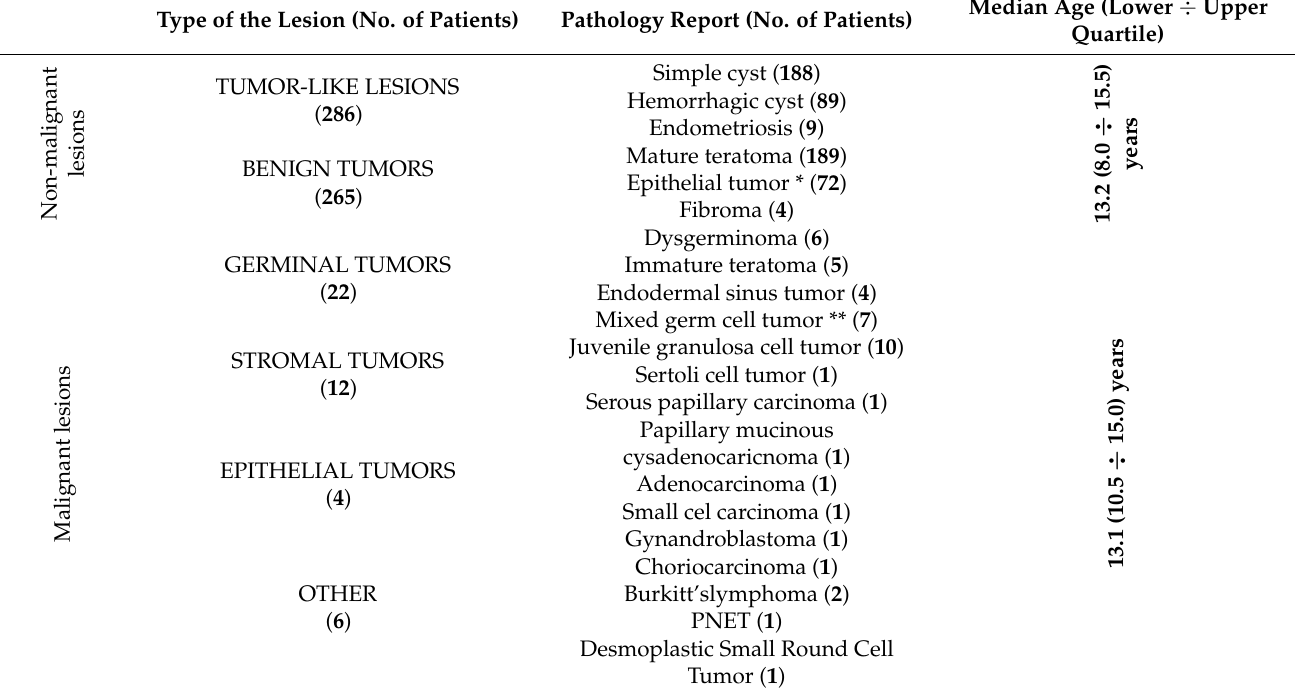
Table 2. Histological